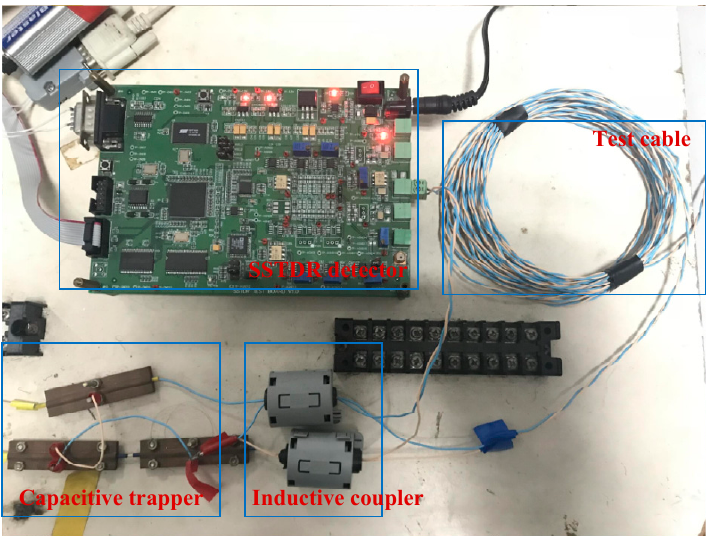
Figure 10. Non-intrusive cable fault diagnosis device.